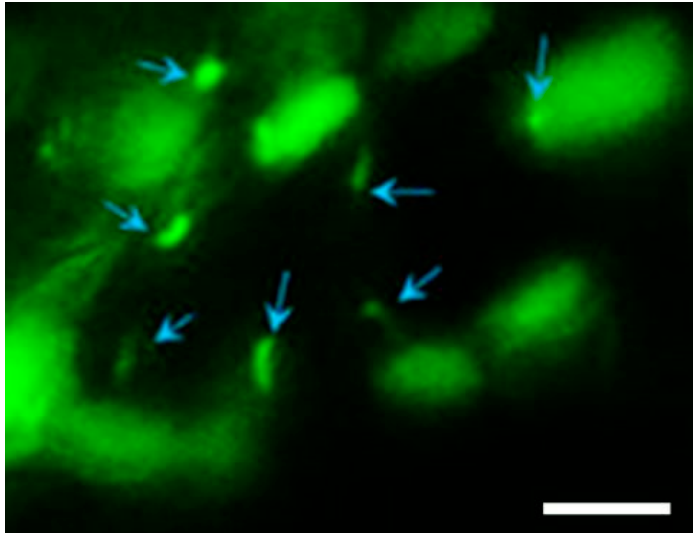
Figure 5. Photomicrograph of primary cilia, denoted by blue arrows. An illustration of GFP-labeled cilial extensions within primordial midbrain channels. Scale bar = 5 µm [22].